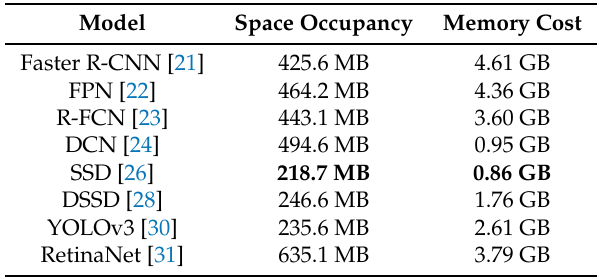
Table 6. Comparison of model size and memory cost. The bold font indicates the best performance.